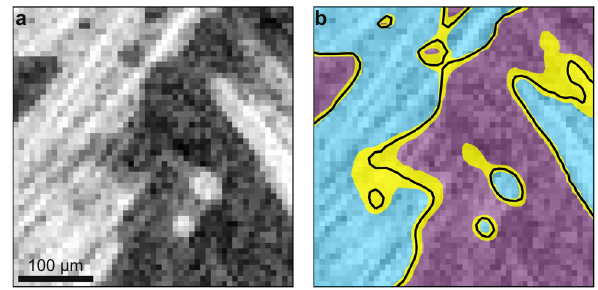
Fig. 1 Illustration of image segmentation and segmentation uncertainty. A grayscale image ( a ) is segmented into white (blue region) and black (purple region) classes in ( b ), with black curves denoting one possible interface boundary between classes. The yellow region is a visual representation of the segmentation uncertainty that results from all possible image